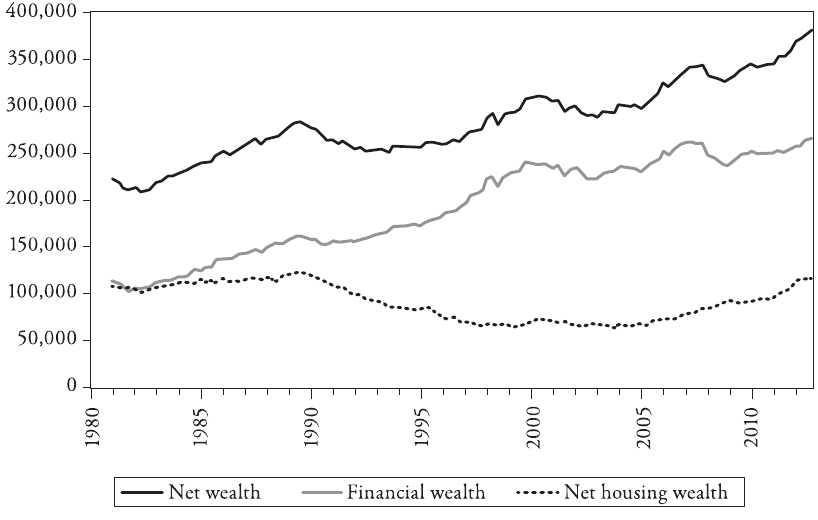
Figure 4: Total Net Wealth, Financial Wealth and Net Housing Wealth (Real, Per Capita. in 2010 Swiss